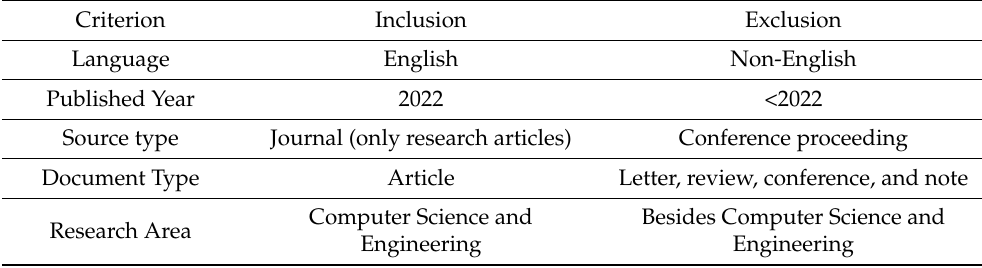
Table 2. Second-stage examination